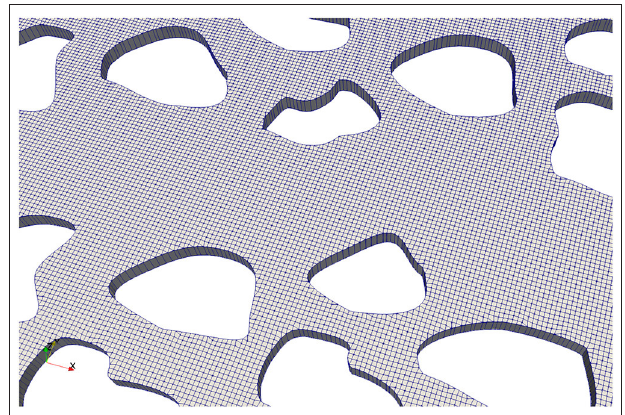
FIGURE 1 | Example of finite-volume grid used in computational